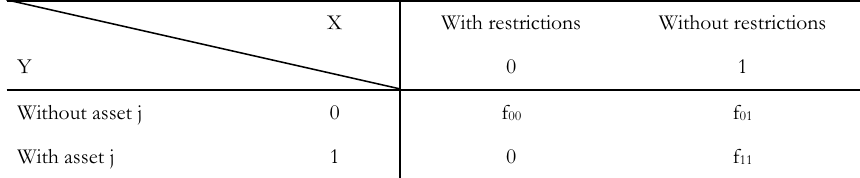
Latent class variable X and investment in asset j